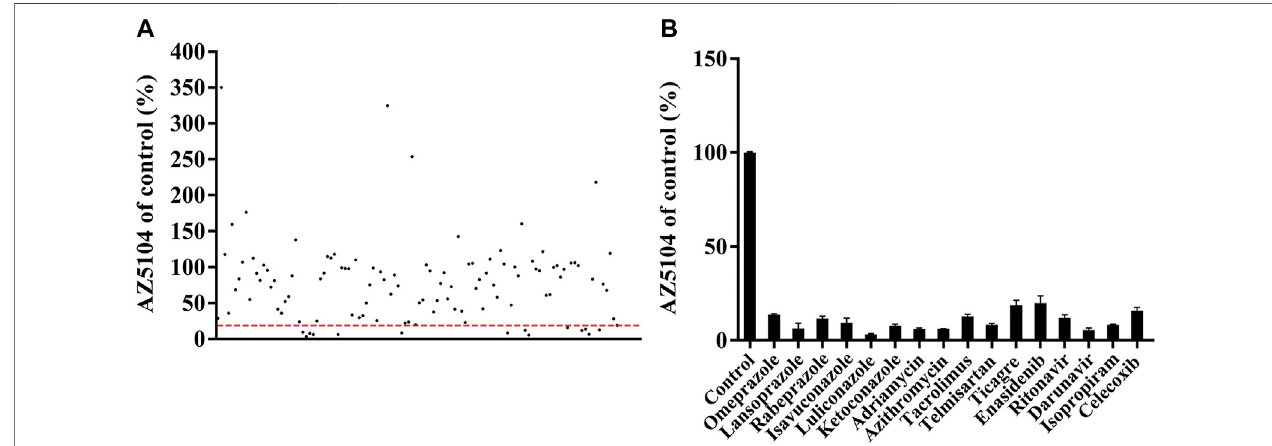
FIGURE 2 | Comparison of the inhibitory effects of drugs (100 μ M) on the metabolism of osimertinib in rat liver microsome (RLM). (A) All drugs screened. Data are presented as the means. (B) The drugs with the inhibition rate > 80% are shown. Data are presented as the means ± SD.